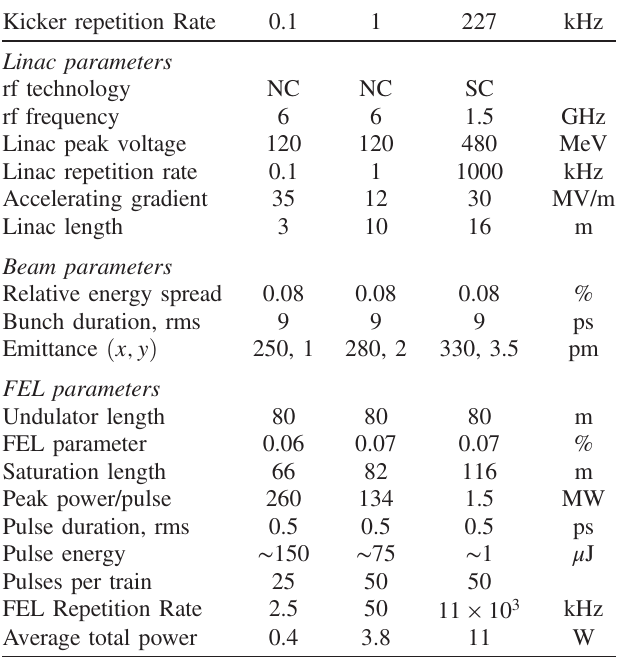
TABLE IV. SR-HG-FEL parameters at equilibrium , for lasing at 4 nm in single and multipass mode, predicted by beam envelope